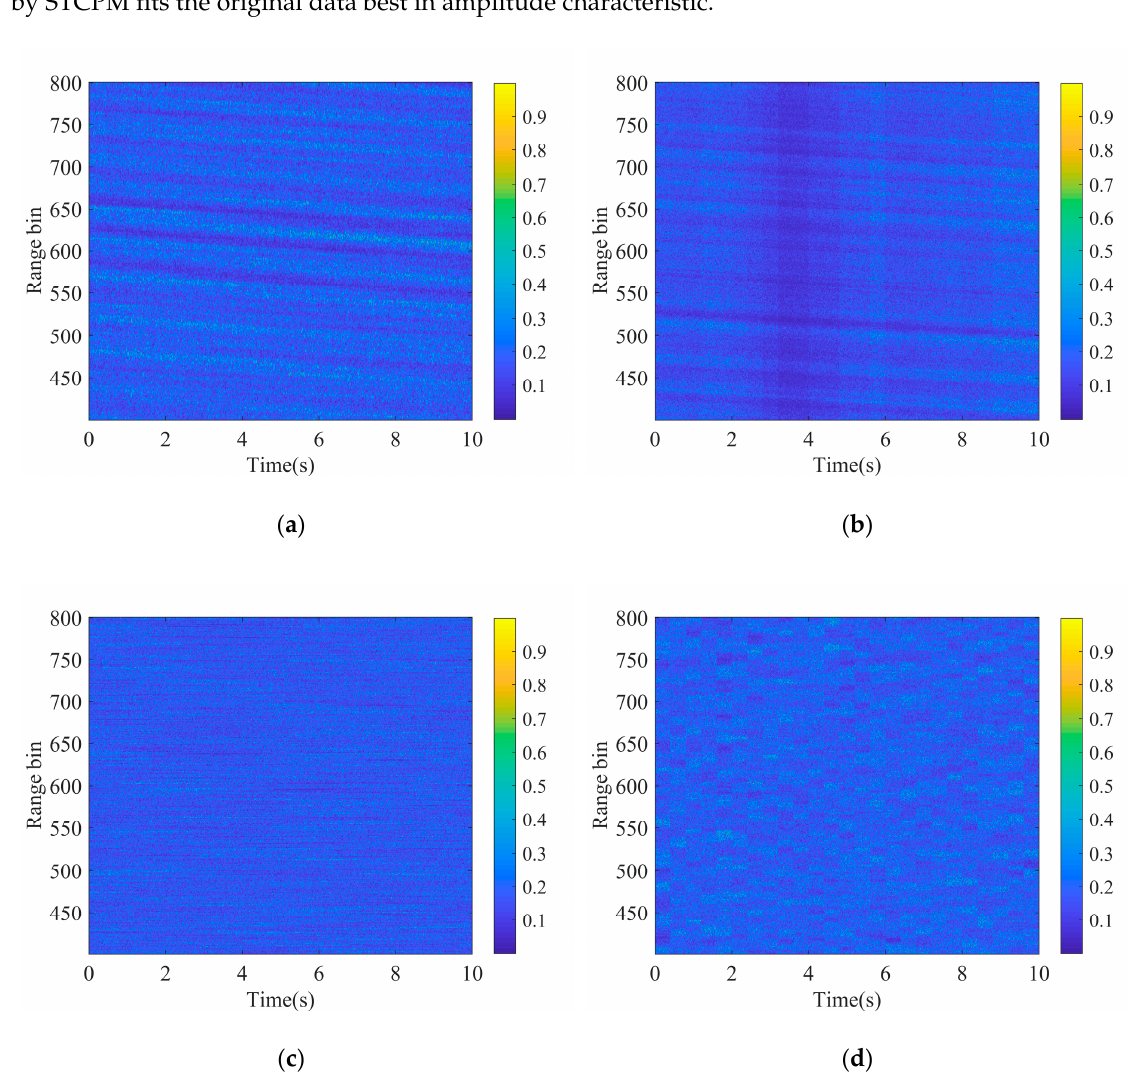
Figure 12. The amplitude-range-time of real and generated clutter: ( a ) Original; ( b ) STCPM; ( c ) TCM; ( d ) SCM.